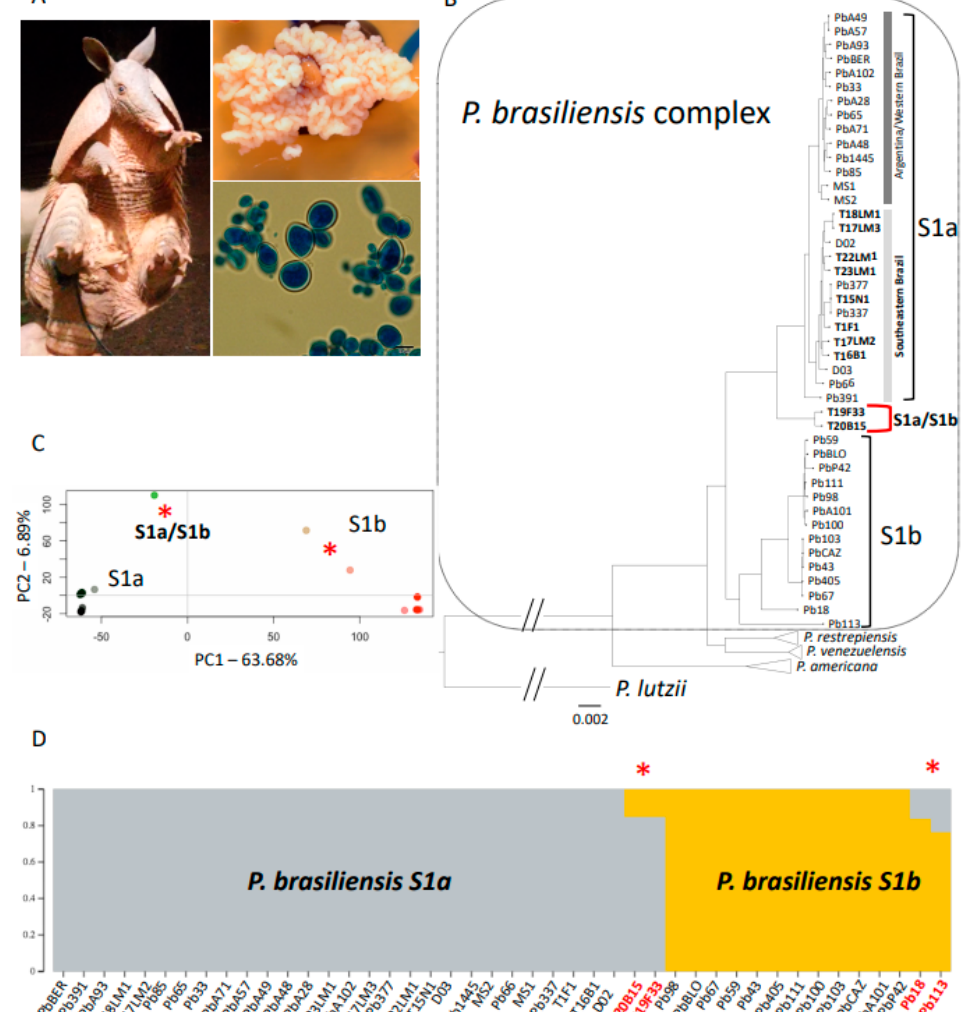
Figure 1. Genetic background of Paracoccidioides brasiliensis isolated from nine-banded armadillos in the Amazon basin. ( A ) Specimen collected, macroscopic characteristics of the fungal growth on tissue, and microscopic characteristics of yeast cells isolated from the tissue. ( B ) Genome-level maximum likelihood tree of 70 Paracoccidioides spp. genomes, indicating the placement of the Amazonian isolates T19F33 and T20B15 as a monophyletic group sister to P. brasiliensis S1a cluster. ( C ) Principal Component Analysis (PCA) reveals that P. brasiliensis S1a and S1b are populations separated along the PC1 axis corresponding to 63.68% of the total variation. ( D ) ADMIXTURE analysis of P. brasiliensis revealed admixed (*) S1a genotypes (T19F33 and T20B15) and S1b genotypes (Pb113 and Pb18). The proportion of admixture of each isolate is represented by height and colors of each of the two populations.